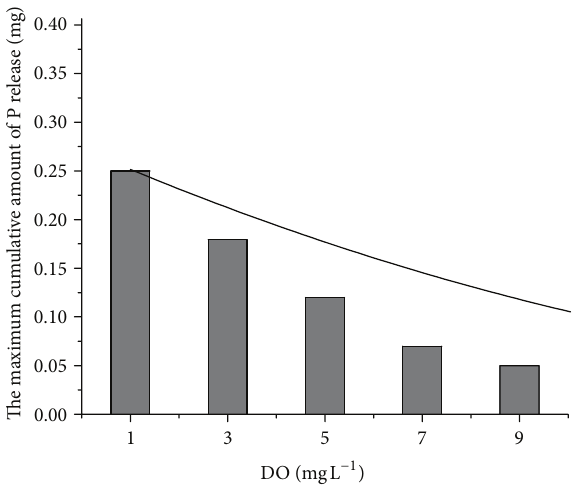
Figure 6: Maximum cumulative amount of P release as a function of DO.